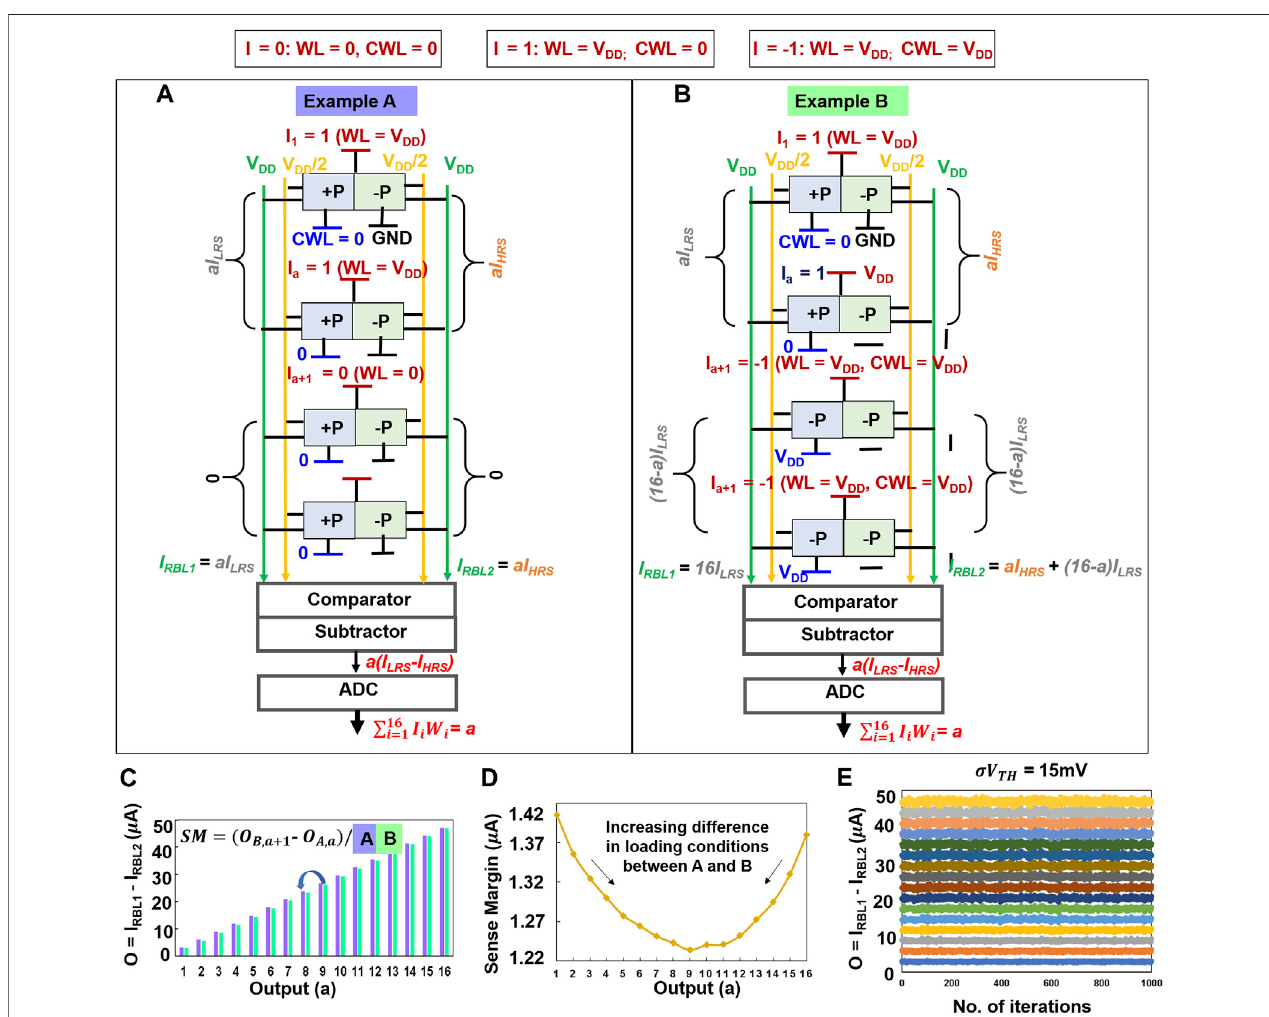
FIGURE 10 | Examples of STeP-CiM for (A) best-case and (B) worst-case loading effect, (C) computation of sense margin, (D) sense margin, and (E) variation analysis for 16 activations.